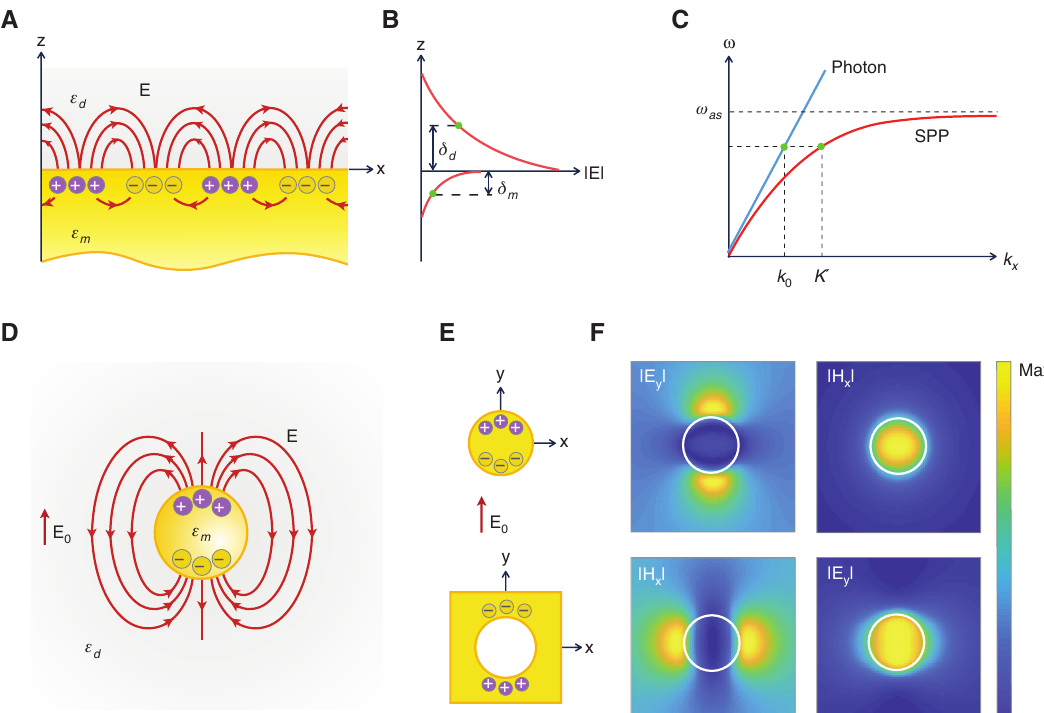
Figure 5: Electromagnetic properties of plasmonic structures. (A) Illustration of the electric field lines and surface charge distribution associated with the SPP supported by a metal-dielectric interface. (B) Magnitude of the electric field across the interface showing the extend of electric field confinement. The penetration depth into the metal ( δ ) and dielectric ( δ ) characterize the SPP mode confinement. (C) Dispersion relations of SPPs (red line) and photons (blue line). The m d wavenumber of an SPP is larger than that of a photon in the dielectric medium and can acquire large values near the resonance frequency asymptote, ω . (D) Illustration of the electric field lines, E, associated with the LSP excited on a metallic nanosphere by an incident electric as field, E . (E) Schematic illustration of the charge distribution in a metal disk (top) and a circular aperture (bottom) due to an incident 0 electric field, E . (F) Calculated near-field distribution in the x , y -plane for a gold disk (top row) and a circular aperture (bottom row) having 0 a diameter of 150 nm and a thickness of 30 nm. The calculations were carried out using the finite-difference time-domain method using a y -polarized plane wave excitation at a wavelength of 750 nm. The white circle indicates the position of the